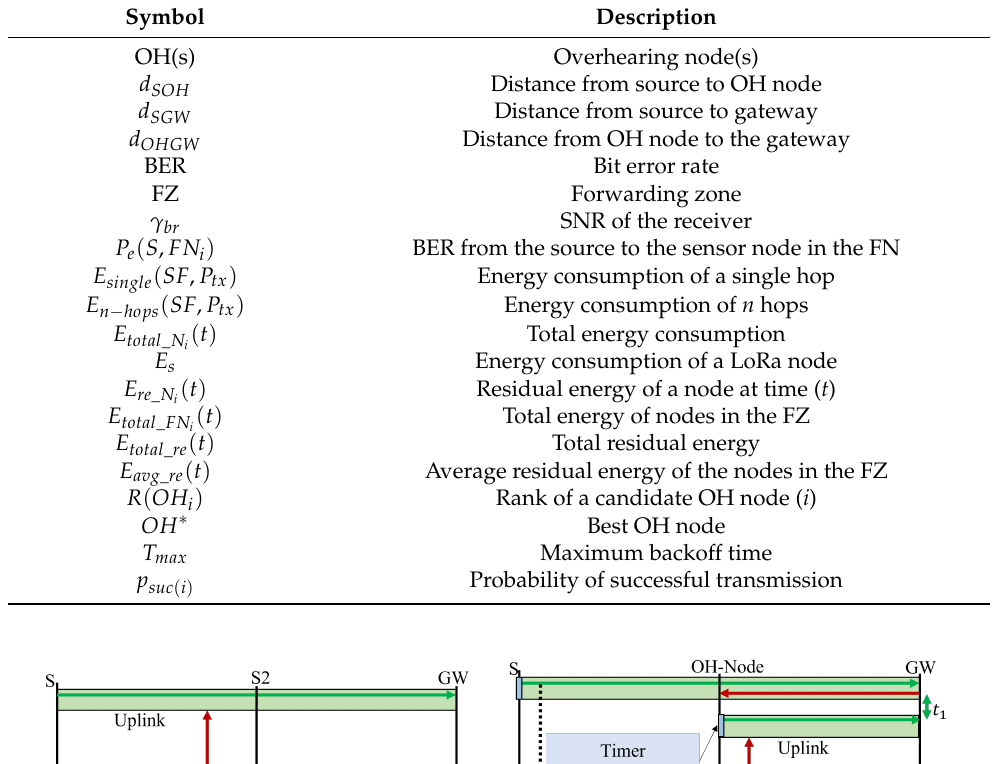
Table 2. List of main notations.